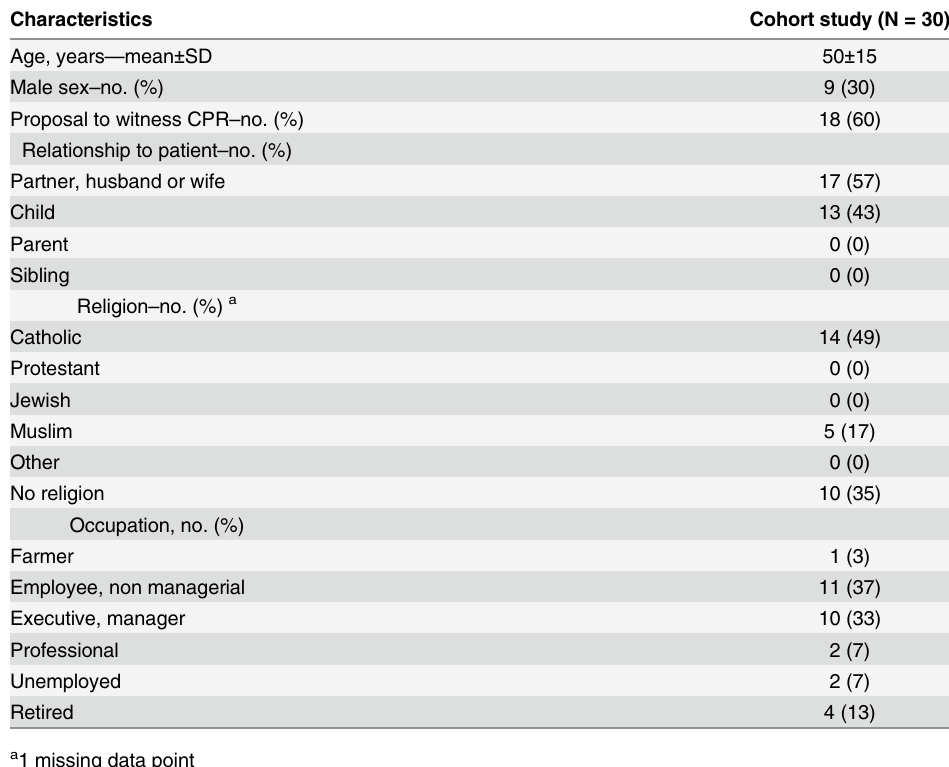
Table 1. Characteristics of the